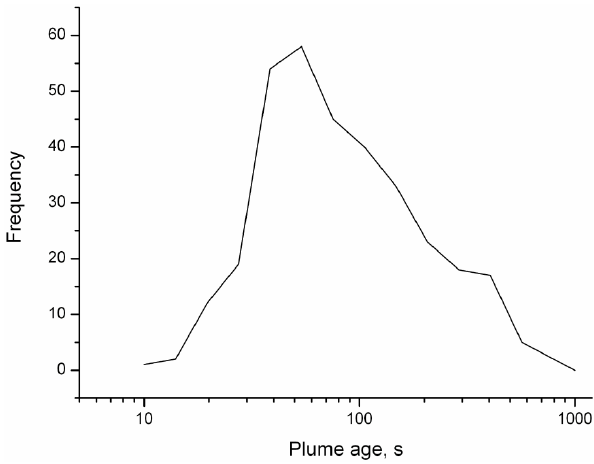
Fig. 5. Distribution of the ages of the measured plumes. Figure 5. Distribution of the ages of the measured plumes. 988